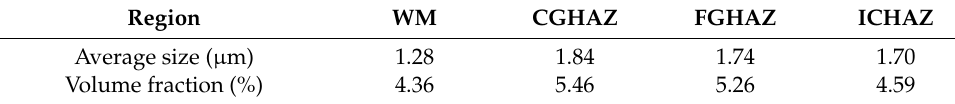
Figure 5. OM images showing the distribution and morphology of MA constituents in different regions. ( a ) WM; ( b ) CGHAZ; ( c ) FGHAZ; ( d ) ICHAZ; ( e ) SCHAZ. Table 2. Average size and volume fraction of MA constituents in different regions. Region WM CGHAZ FGHAZ ICHAZ Average size ( μ m) 1.28 1.84 1.74 1.70 Volume fraction (%) 4.36 5.46 5.26 4.59